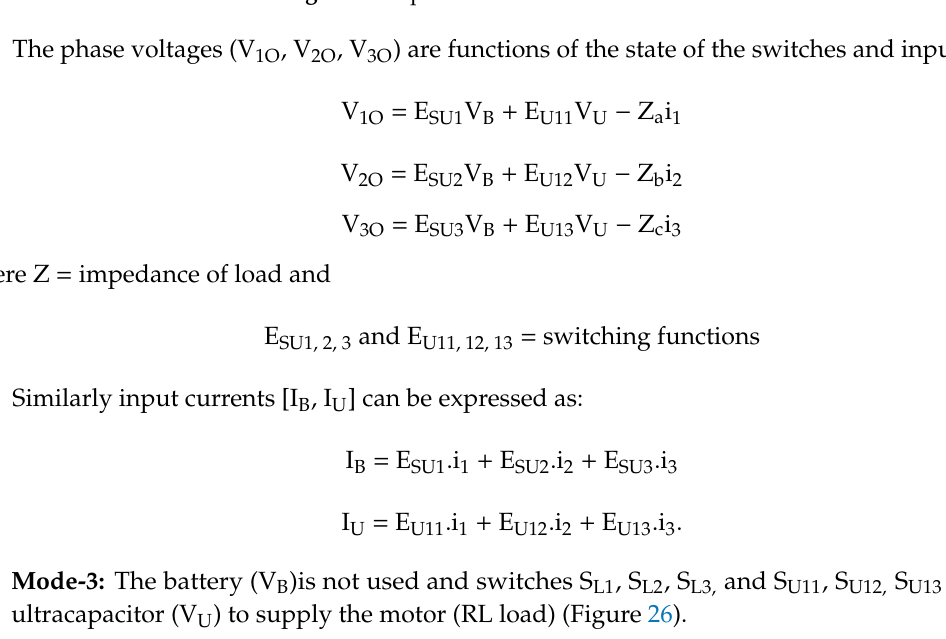
Figure 25. Operation of circuit under mode-2.